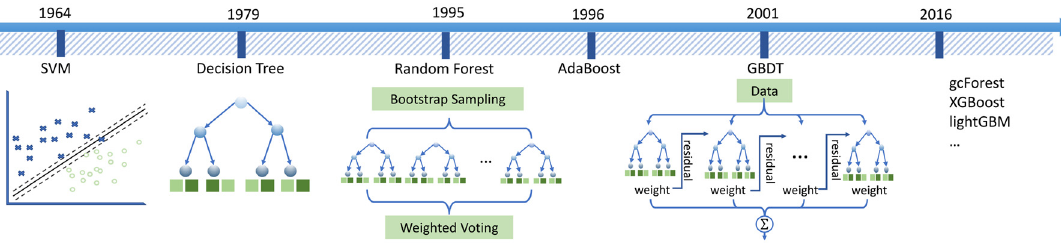
Figure 11. A development timeline based on the mainstream methods of feature classification.